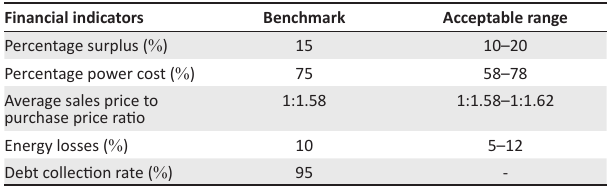
TABLE 2: Electricity distribution cost benchmarks. Financial